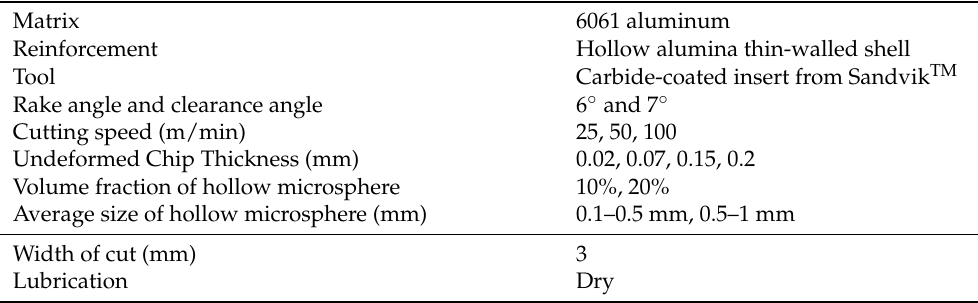
Figure 3. ( a ) Machining set-up, ( b ) sample cutting force trace collected from the tests, ( c ) representa- tive machined chip. Table 4. Machining factors for 6061-based syntactic